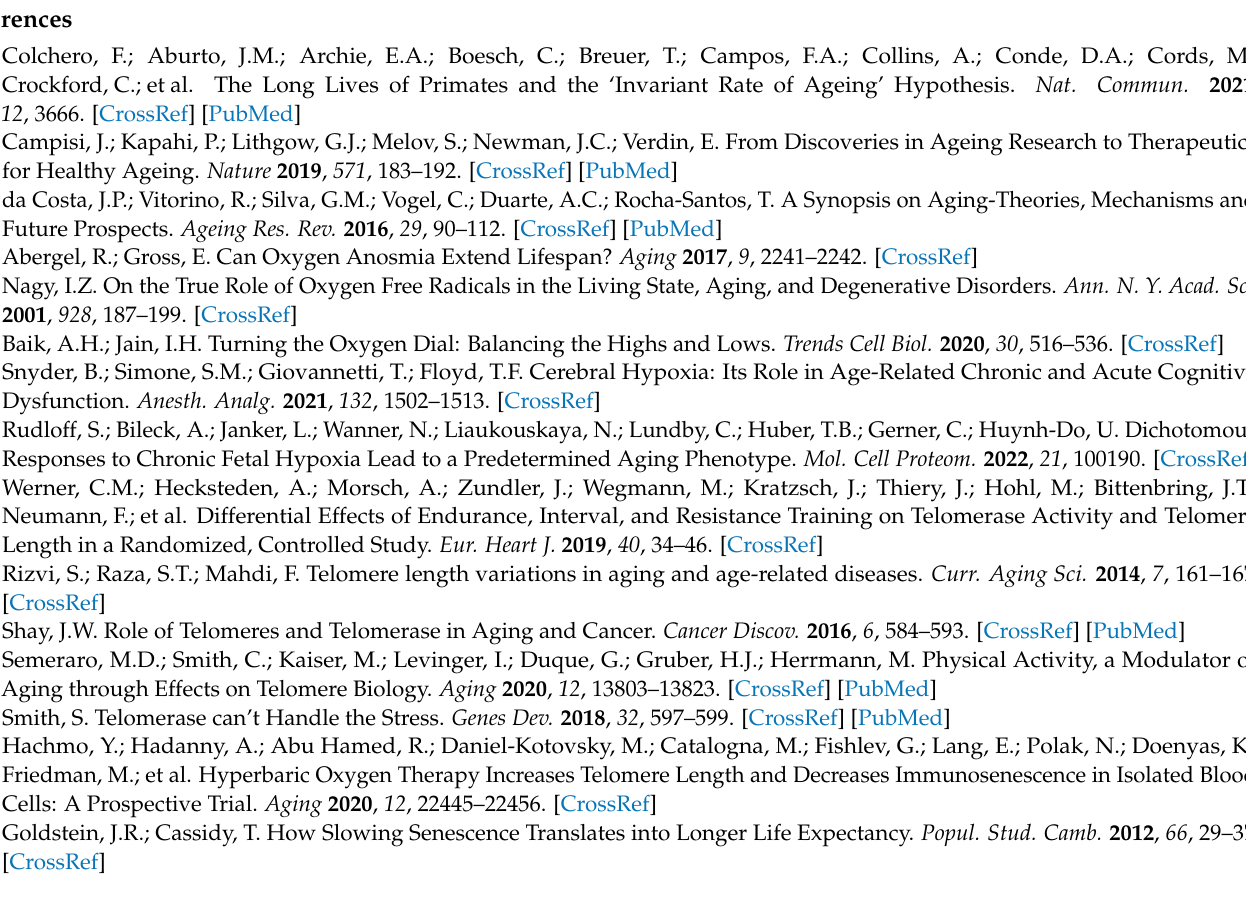
Table S2. Summary of variables. Table S3. The Moran’s I index of spatial effects of life expectancy between provinces and municipalities. Table S4. Results of multiple linear regression. Figure S1. Dis- tribution maps of potential confounders at the provincial level in China. Figure S2. Distribution maps of potential confounders at the municipal level in